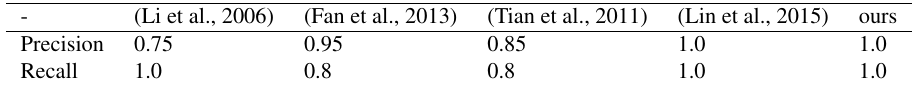
Figure 5: An example of experimental results on dataset PETS2007 from camera 3. Green line connects the bag with its owner. The yellow bounding box indicates a un-owner moving the bag while the red one indicates the man as a theft.